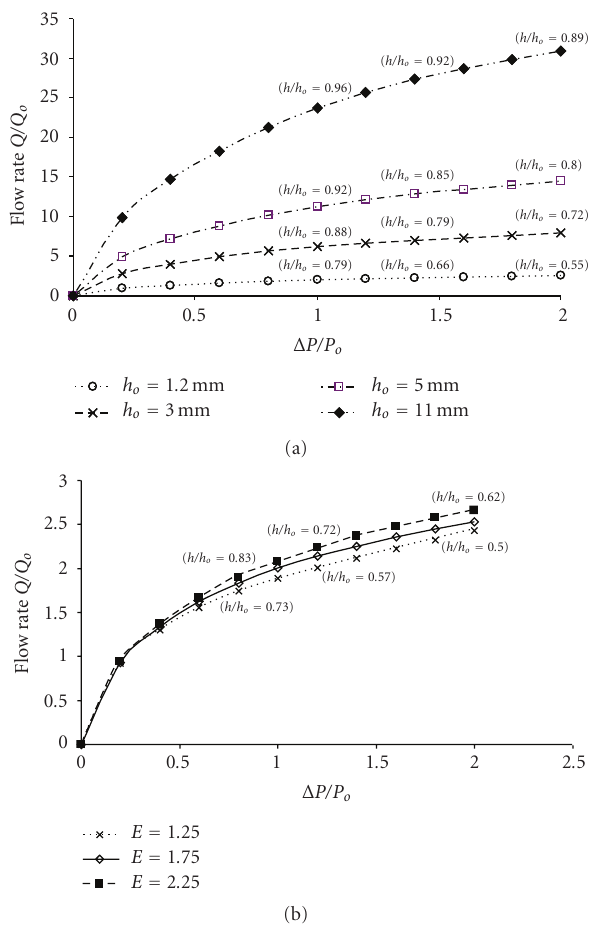
Figure 5: Parametric investigation (a) e ff ect of initial airway opening h o on flow rate Q and constriction height h for a fixed tongue replica modulus E = 1 . 75MPa, (b) e ff ect of tongue modulus E on flow rate Q and constriction height h for a fixed initial opening h o = 1 . 2mm ( Q o = 10L/min, P o = 100Pa, and h o = initial constriction height).